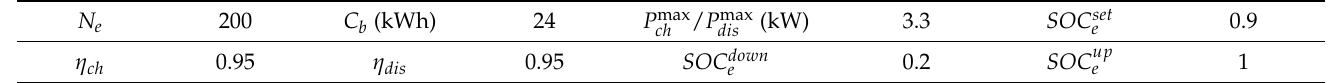
Table 8. Lighting equipment parameters.